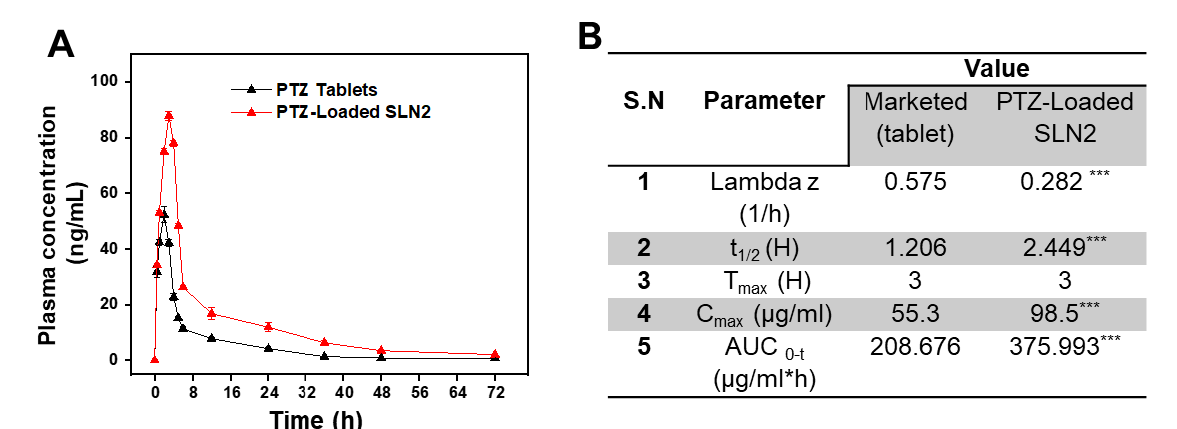
Figure 6. Pharmacokinetics profile of PTZ-loaded SLN2 and free PTZ marketed tablets. ( A ) Plasma concentration-time curve after a single oral dose (5 mg/kg) of PTZ-SLN2 in rats (n = 6), compared to free PTZ (5 mg/kg). Time points are indicated; ( B ) determination of pharmacokinetic param- eters (n = 5). Data are expressed as mean ± SD (n = 3). *** p < 0.001 indicated high significant statistical difference.